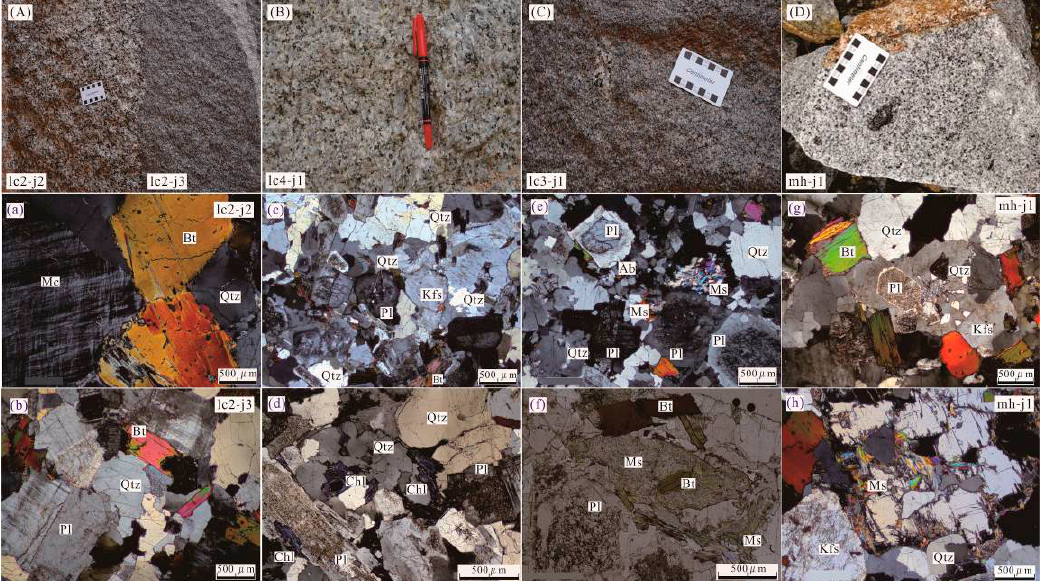
Fig.2 Petro-mineralogical diagram of Lincang granite: (A) granodiorite was intruded by medium-fine grain biotite Figure 2. Petrological diagram of QN and MH granites: ( A ) granodiorite was intruded by monzogranite; (B) Medium-coarse grain biotite monzogranite; (C) & (D) Granodioritc xenoliths are observed in the monzonitic medium–fine-grained biotite granite; ( B ) medium–coarse-grained biotite granite; ( C , D ) granodioritc granites; (a) crosshatch twins of microline; (b) carlsbad twin of plagioclase; (c) & (g) quartz occurs as anhedron fill into the interspace of plagioclase; (d) & (g) plagioclase altered to serisite and (d) biotite altered to chlorite; (e) albite occurs as anhedron; xenoliths are observed in the monzonitic granites; ( a ) crosshatch twins of microline; ( b ) carlsbad twin (f) biotite was replaced and altered to muscovite; (h) muscovite occur as sheet structure; of plagioclase; ( c , g ) quartz occurs as anhedron fill into the interspace of plagioclase; ( d , g ) plagioclase Qtz － Quartz;Pl － Plagioclase;Ab － Albite; Bt － Biotite;Ms － Muscovite; Chl － Chlorite; Ep － Epidote; Ilm － Ilmenite; Aln － altered to serisite and ( d ) biotite altered to chlorite; ( e ) albite occurs as anhedron; ( f ) biotite was replaced and altered to muscovite; ( h ) muscovite occurs as sheet structure; Qtz—Quartz;